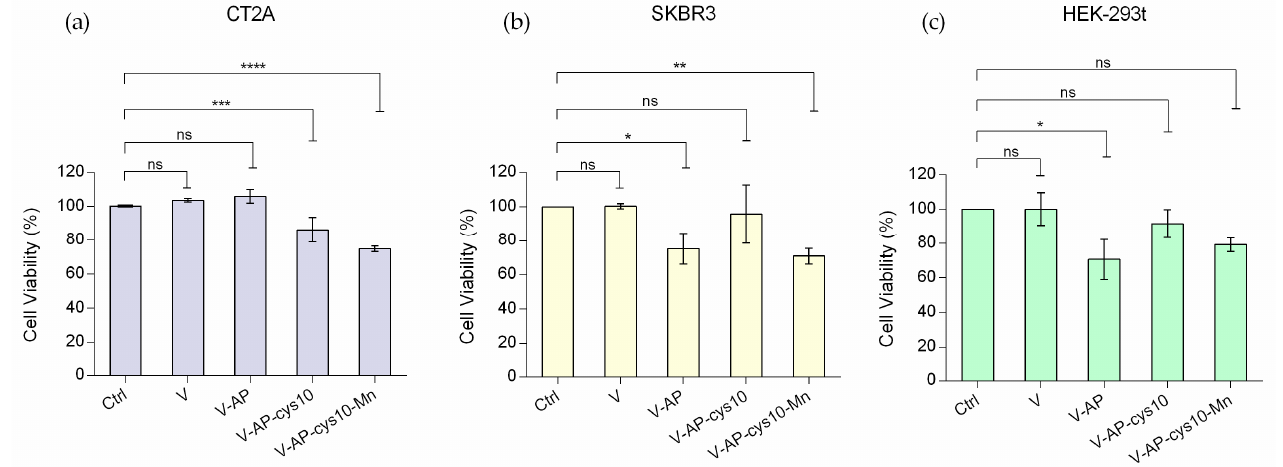
Figure 5. Variation in cell viability during the functionalization process of the starting material.